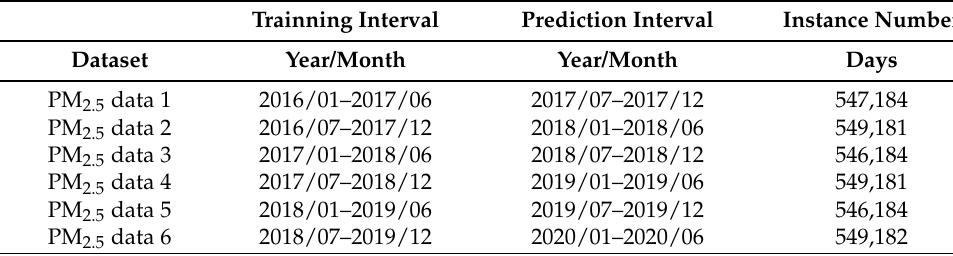
Table 3. Description of the Beijing daily PM 2.5 concentration experimental